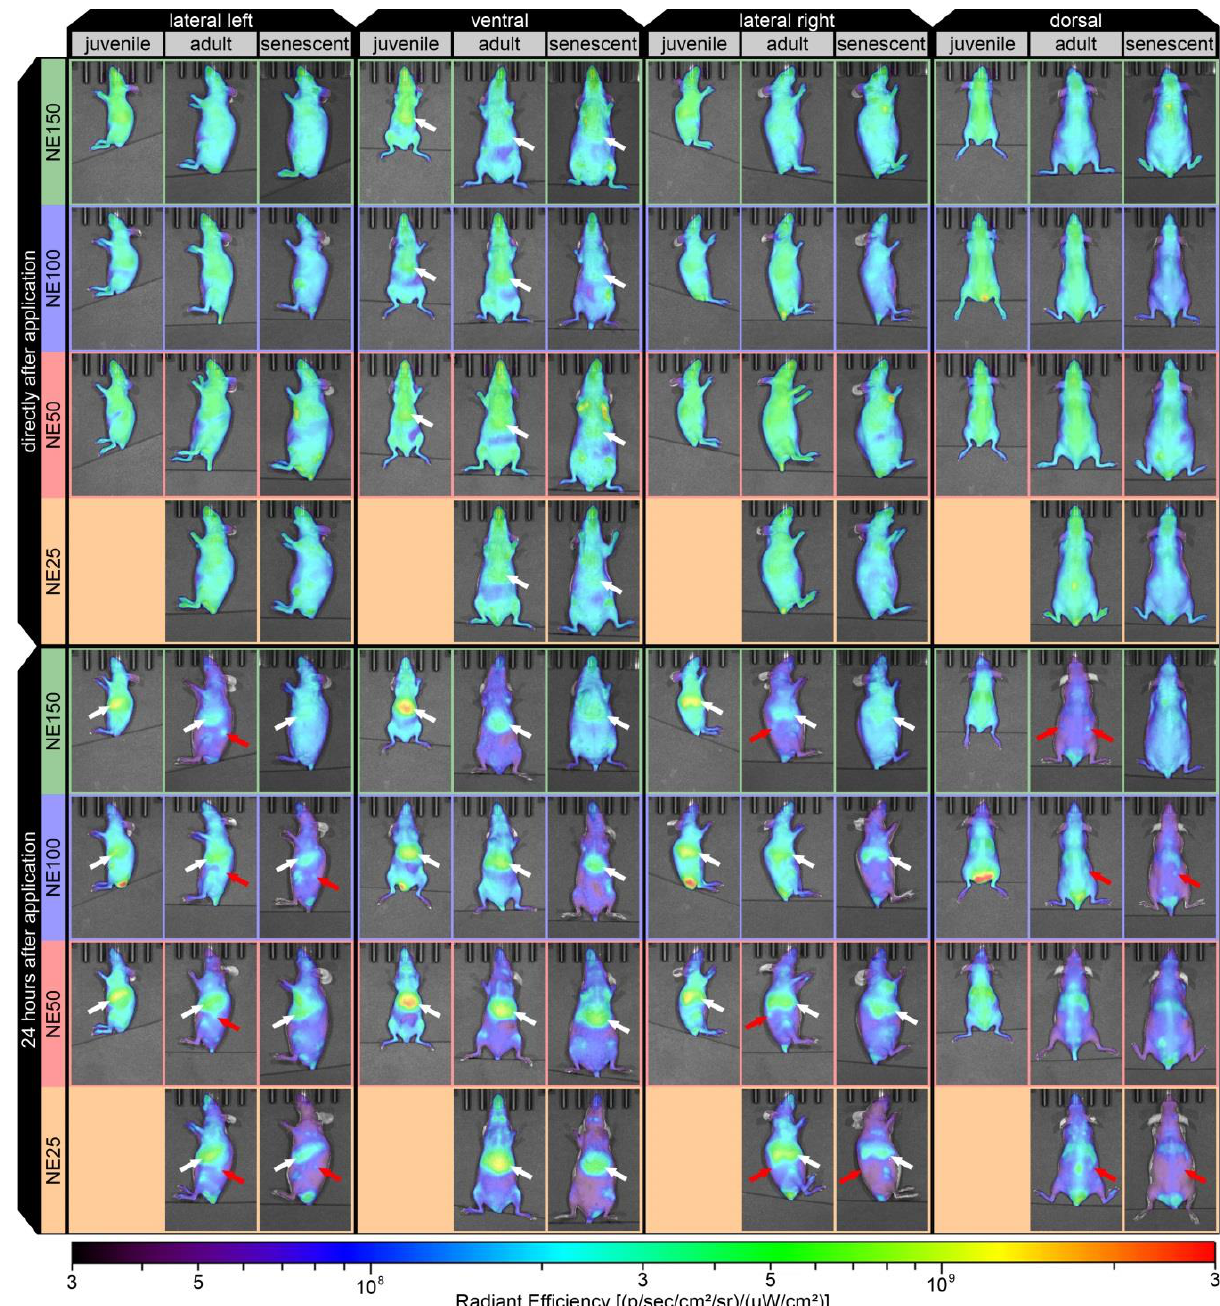
Figure 5. Noninvasive in vivo fluorescence images of representative mice directly after (5 – 10 min) and 24 h after i.v. injection in the tail vein of the four nanoemulsions in juvenile prepubescent (age 3 – 4 weeks), adult (age 12 – 39 weeks), and senescent mice (age > 48 weeks).